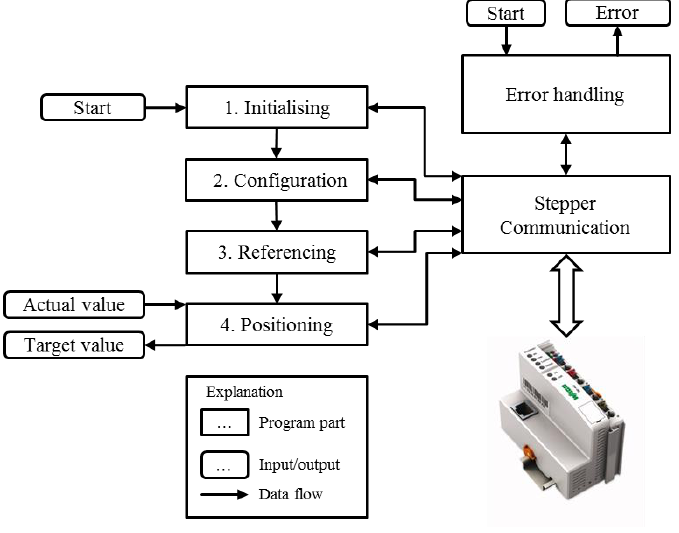
Figure 9. Structure of the programmable logic controller